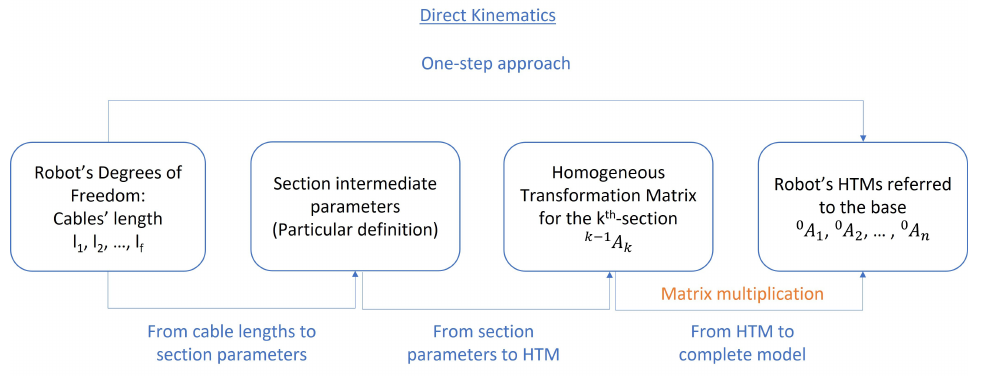
Figure 2. Summary of the different steps for direct